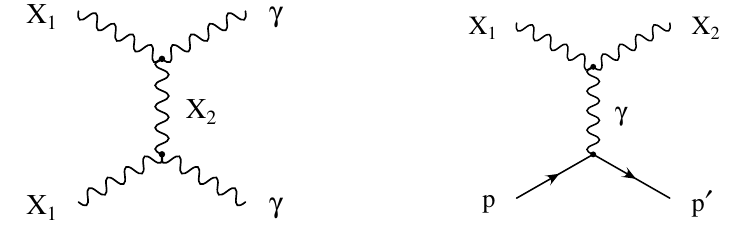
Figure 1 . Left: example t -channel diagram for dark matter annihilation into photons. There is also the crossed u -channel diagram. Right: diagram for dark matter scattering off